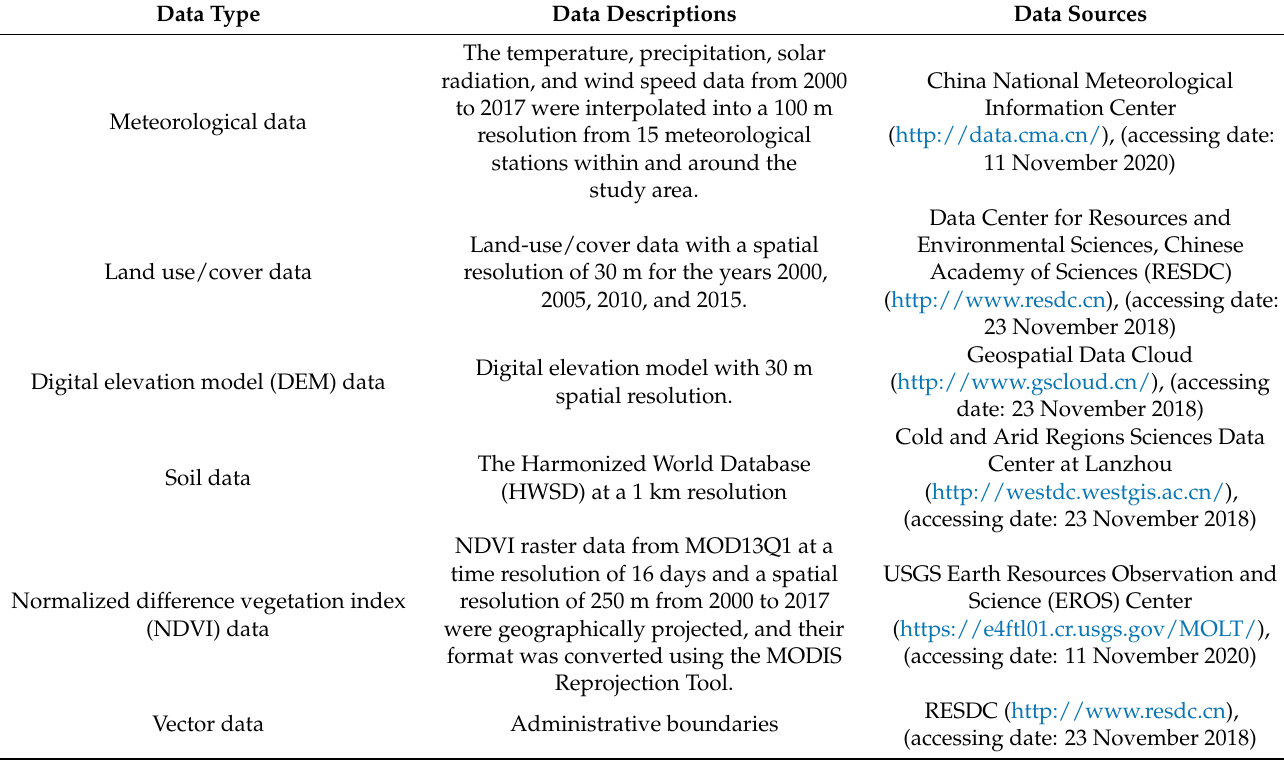
Table 1. Descriptions and sources of the study